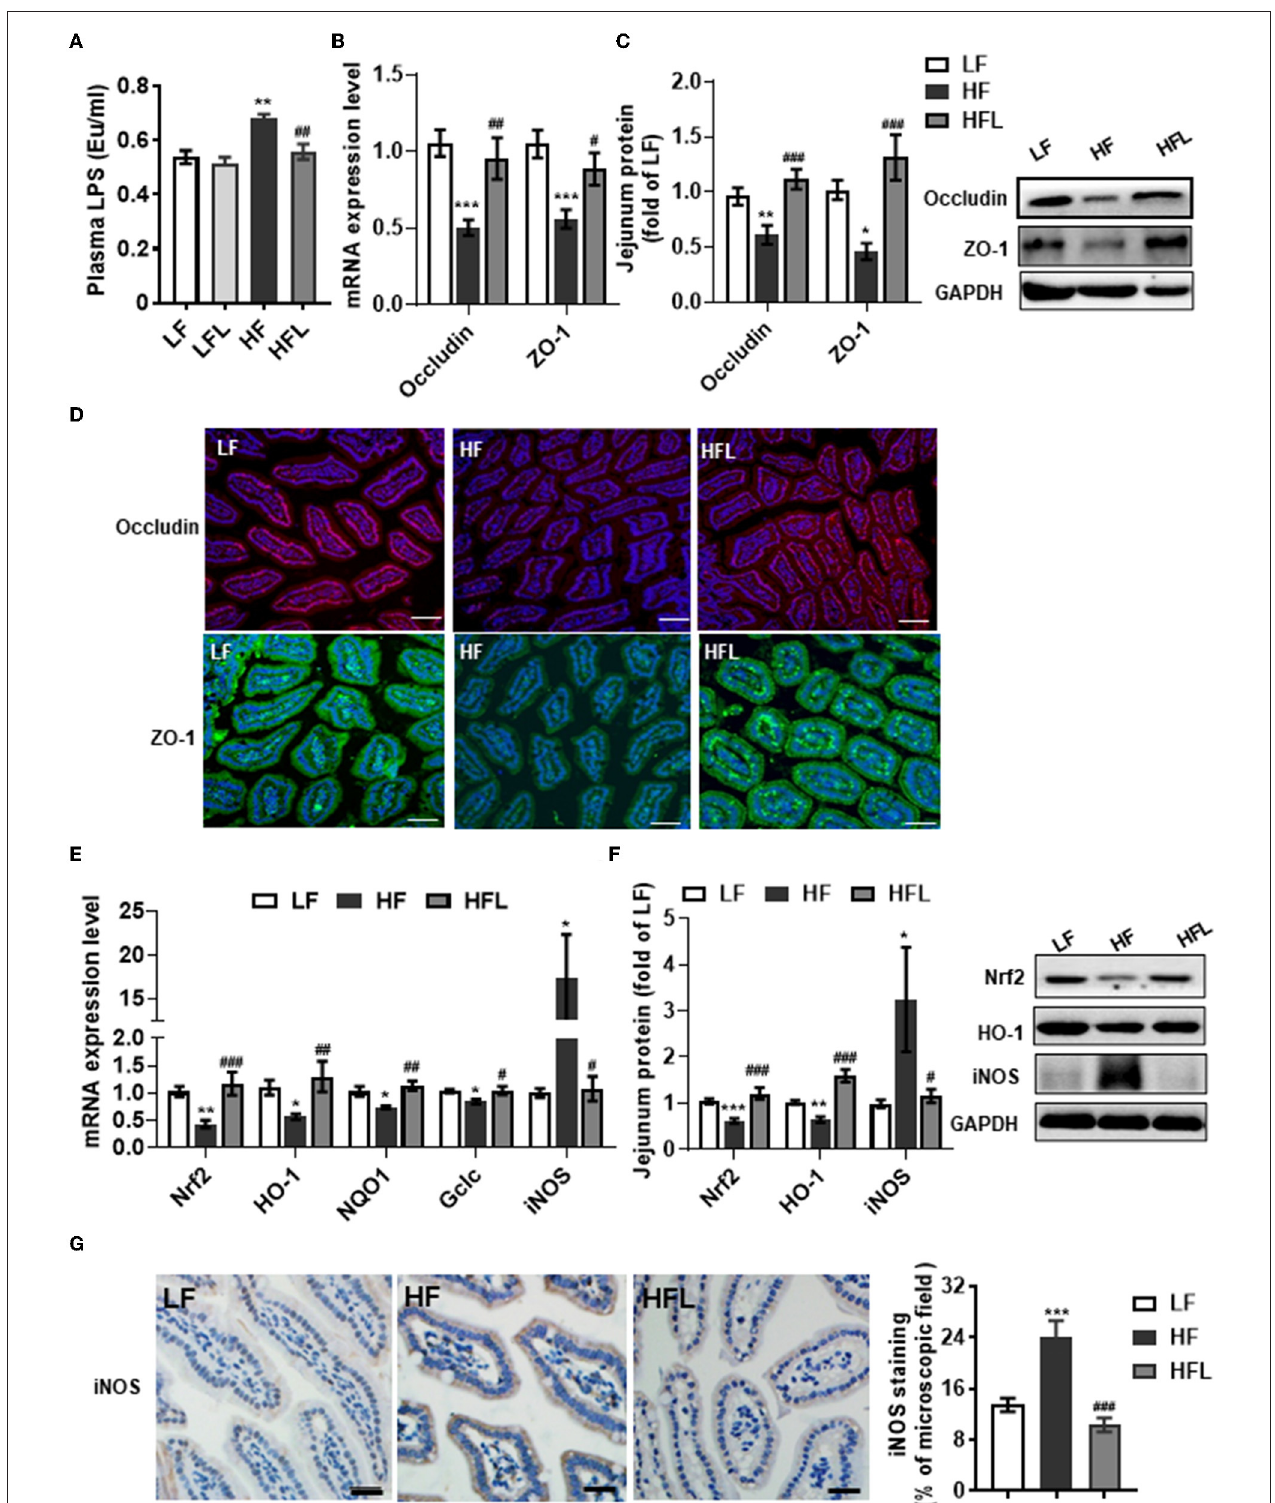
FIGURE 3 | Lentinan improved intestinal barrier integrity and oxidative stress in the jejunum in HF mice. (A) Serum LPS levels. (B) The mRNA levels of occludin and ZO-1 in the jejunum. (C) Protein levels of occludin and ZO-1 in the jejunum. (D) Immunofluorescence staining of occludin and ZO-1 proteins in the jejunum sections. (E) The mRNA levels of Nrf2, HO-1, NQO1, Gclc, and iNOS in the jejunum. (F) Protein levels of Nrf2, HO-1, and iNOS in the jejunum. (G) iNOS protein staining of